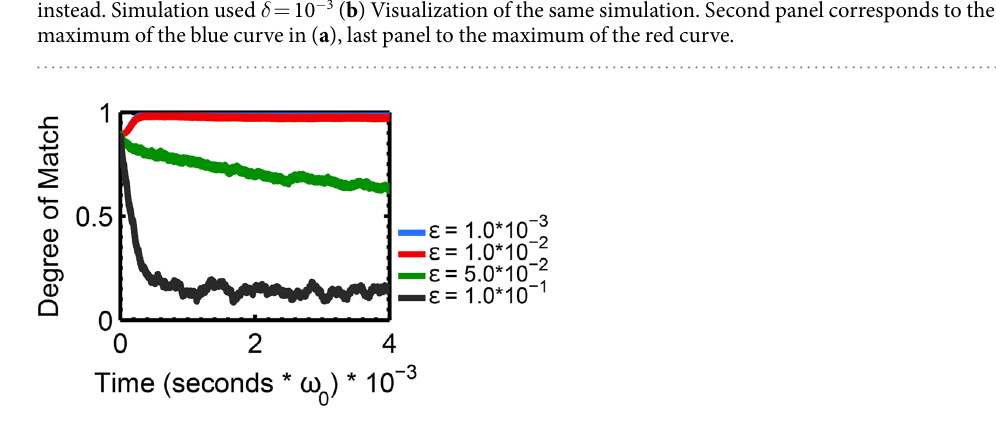
Figure 5. Plot of degree of match with the “a” pattern for varying levels of noise, averaged over ten realizations. Simulations contain κ = 0.1, δ = 10 − 4 , σ = 10 − 4 , ρ = 0.025. At noise levels up to = − 10 2  , the degree of match parameter remains stable over time. At higher noise levels, the system is unstable. These noise amplitudes correspond to the highly aperiodic regime (as shown in Supplementary Information), so the failure to synchronize is